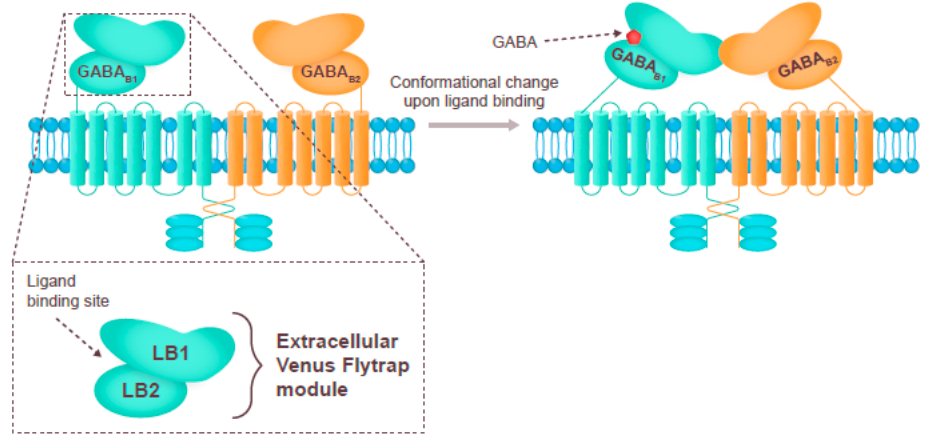
Figure 2. The structure of the GABA B receptor, its ligand binding site, and the downstream signaling elements [39,40]. GABA, gamma-aminobutyric acid; LB, ligand binding.